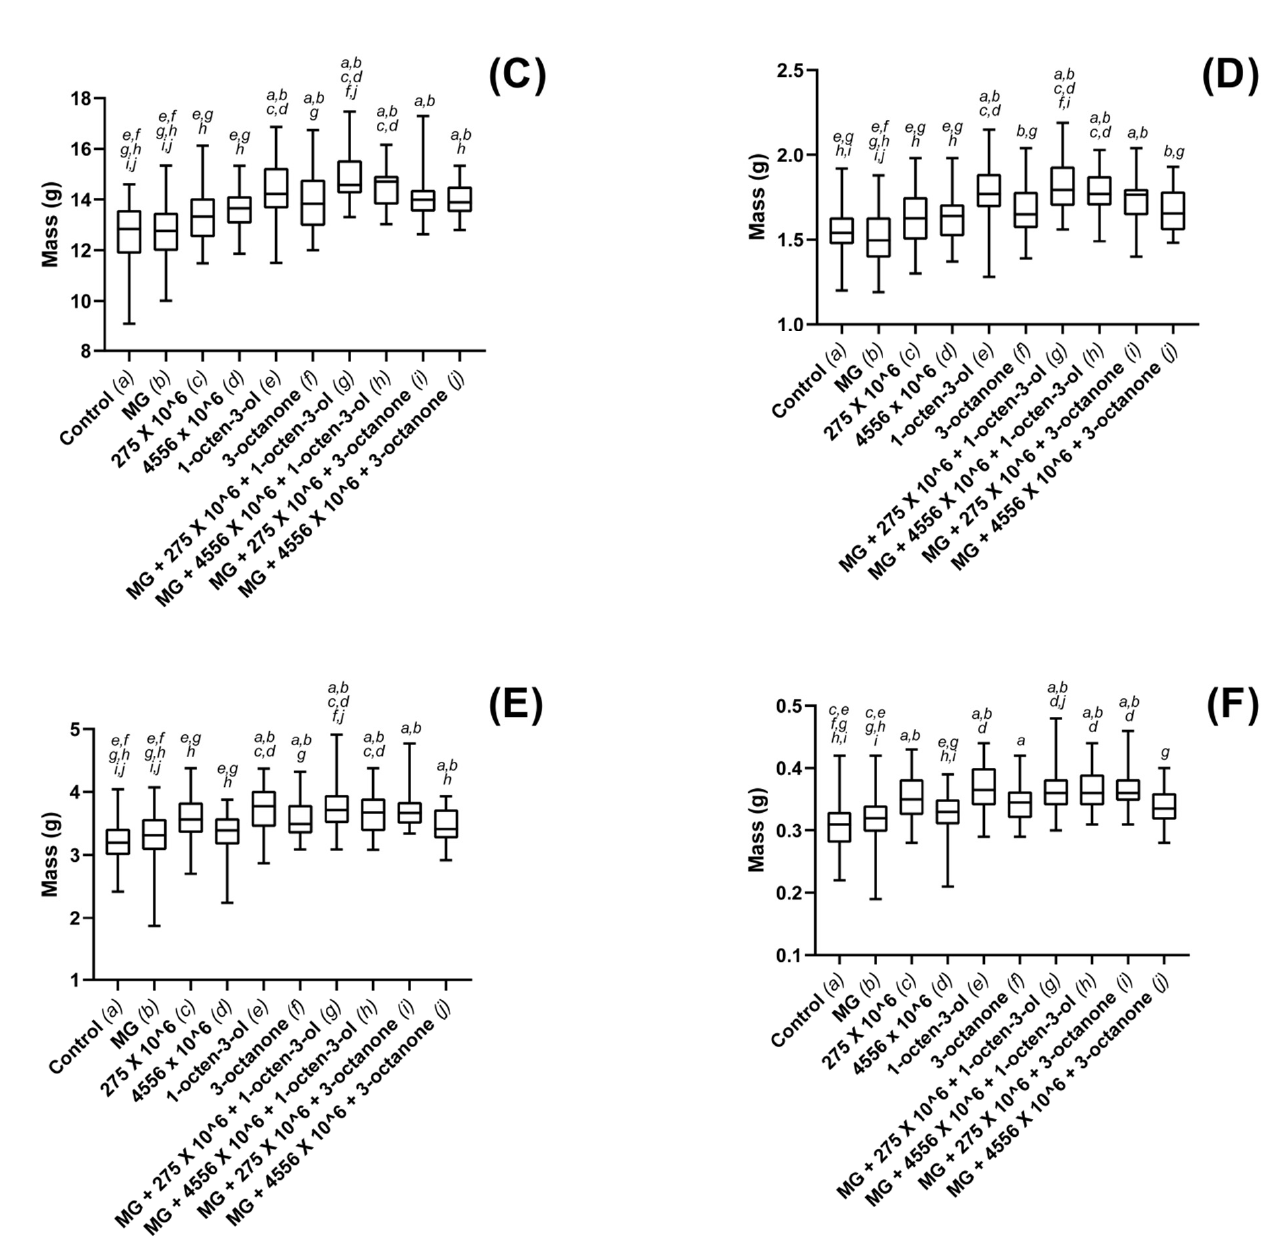
Figure 3. Plant growth metrics for oilseed rape plants exposed to M. brunneum , M. brunneum - derived VOCs and hydrogels. ( A ) whole-plant fresh mass, ( B ) whole-plant dry mass, ( C ) fresh shoot mass, ( D ) dry shoot mass ( E ) fresh root mass and ( F ) dry root mass, recordings for plants grown in composts treated with hydrogels (MG), M. brunneum strains: V275 or 4556, 1-octen-3-ol, 3-octanone or combinations thereof. All M. brunneum applications were standardized at 1 × 10 6 conidia g − 1 compost, and all VOCs were added at a rate of 1 µ L 100 g − 1 compost. Hydrogels were added according to manufacturer specification. Controls were grown in untreated composts. Plants were grown in a glasshouse maintained at 25 ± 2 ◦ C for a total of six weeks. Controls were exposed to compost media without additional treatment. Figure display’s minimum, 1st quartile, median, 3rd quartile and maximum measurements within the treatment groups. Significant results denoted between treatments using letters ( a – j ) above each boxplot; where denotation letters are absent, no significant differences were detected between treatments. Key: 275— M. brunneum (Strain: V275); 4556— M. brunneum (Strain: ARSEF 4556); MG—MiracleGro